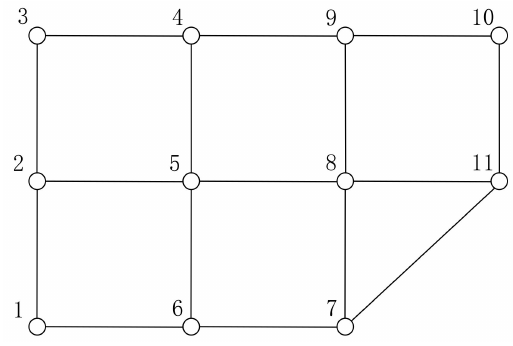
Figure 1. Simple example of a road